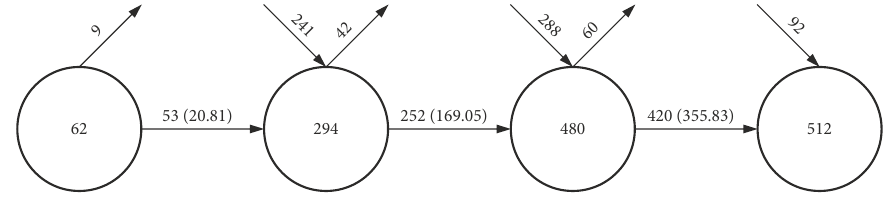
Figure 5. The overlapping map of